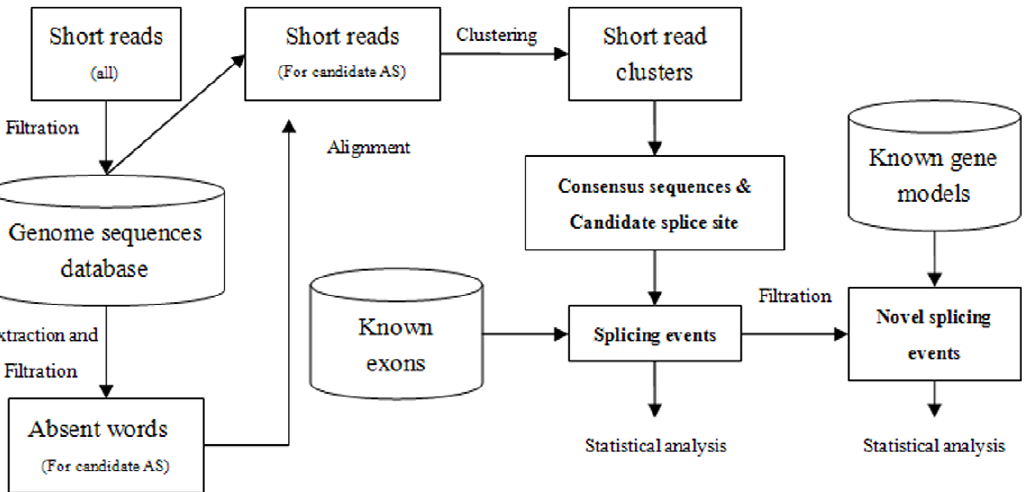
Figure 3. General scheme for splicing event identification by SAWs. Note that filtration against known gene models is only necessary for identification of novel splicing events.